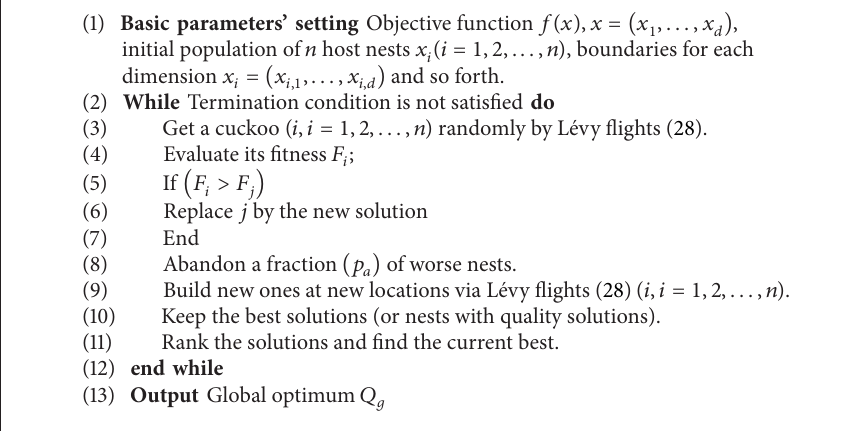
Algorithm 1: The basic steps of the cuckoo search.